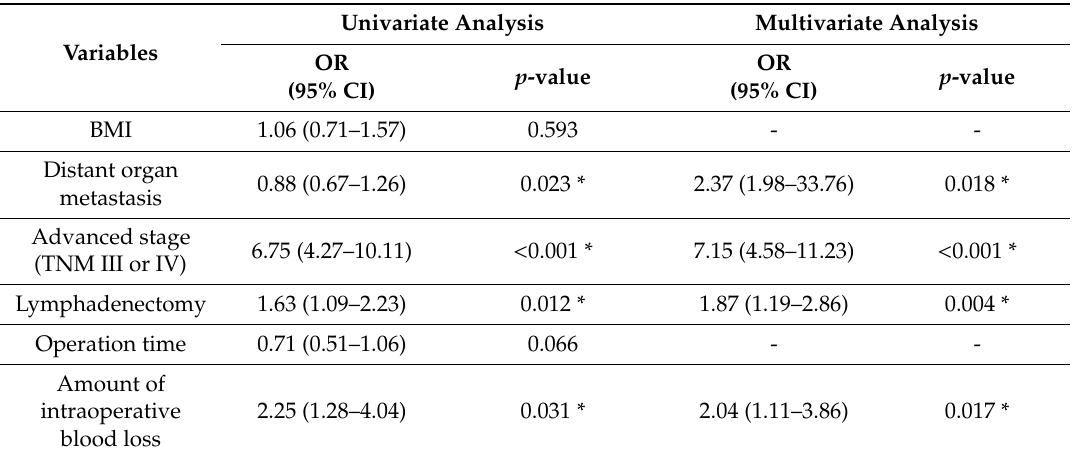
Table 4. Results of univariate and multivariate analyses of possible predictive